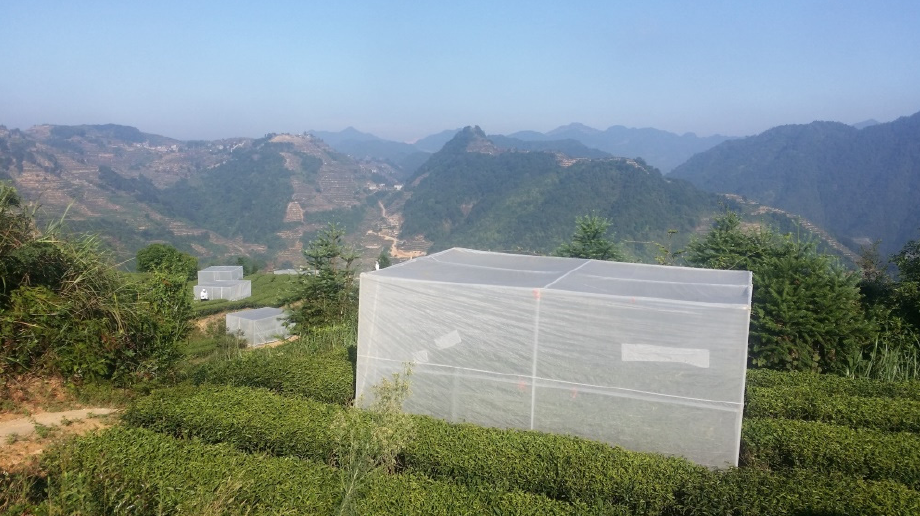
Figure 4. Photo of the cages in the exclosure experiment, Hongxing tea plantation (25°0 ′ 15.76 ″ N, 117°52 ′ 0.04 ″ E; 700–750 m elevation).